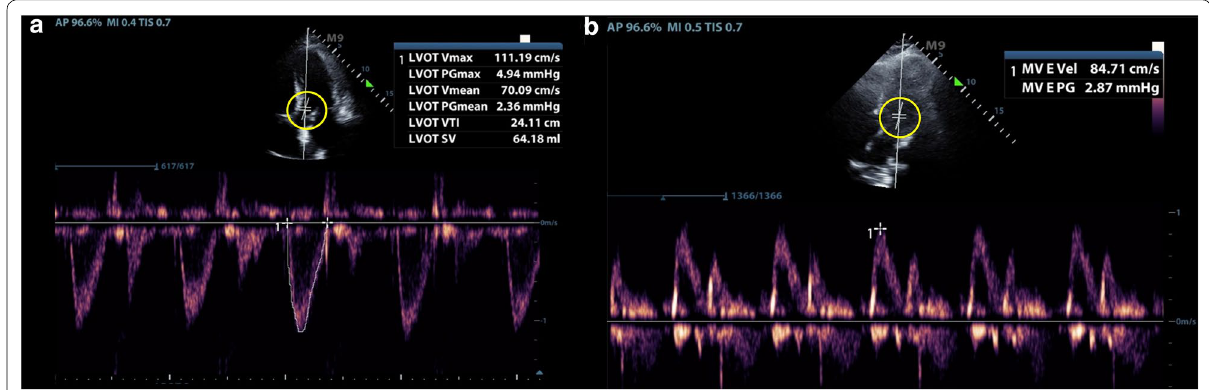
Fig. 1 Angle correction (circles) in pulsed-wave Doppler on echocardiography, a practice that is not recommended and was performed in the study of Betcher et al. [1]. a Left ventricle outflow-tract flow; b transmitral flow. Alignment between the flow and the Doppler must be performed manually and thus requires an excellent technique, without electronic angle